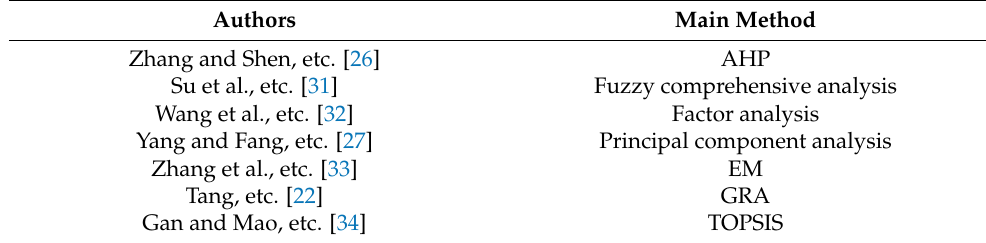
Table 1. Evaluation methods of city–industry integration. Authors Main Method Zhang and Shen, etc. [26] AHP Su et al., etc. [31] Fuzzy comprehensive analysis Wang et al., etc. [32] Factor analysis Yang and Fang, etc. [27] Principal component analysis Zhang et al., etc. [33] Gan and Mao, etc. [34]